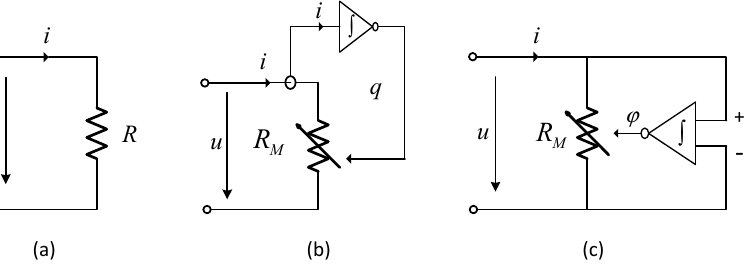
Figure 1. Schematic diagrams: ( a ) circuit diagram of the resistor; ( b ) circuit diagram of the current- controlled memristor; and ( c ) circuit diagram of the volt-controlled memristor.